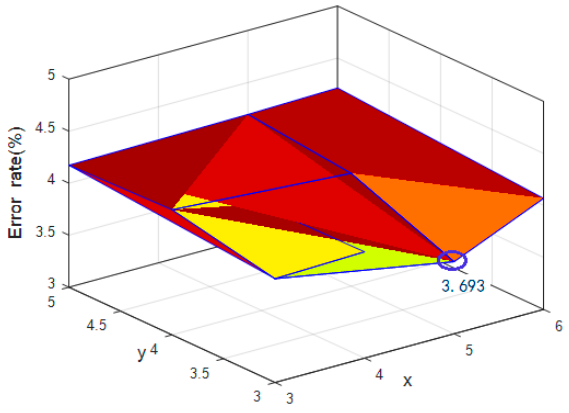
Figure 10. The error rate of test set under different learning module numbers (where z = 4).